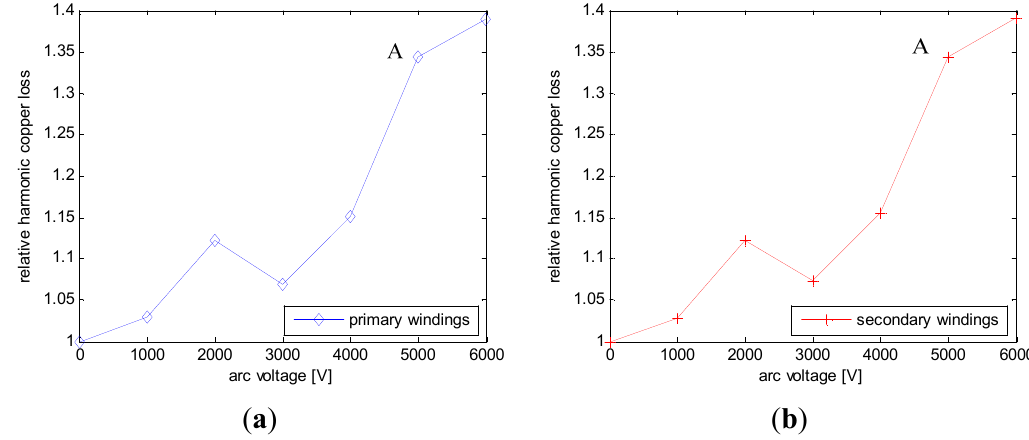
Figure 12. ( a ) Primary relative harmonic copper loss and ( b ) Secondary relative harmonic copper